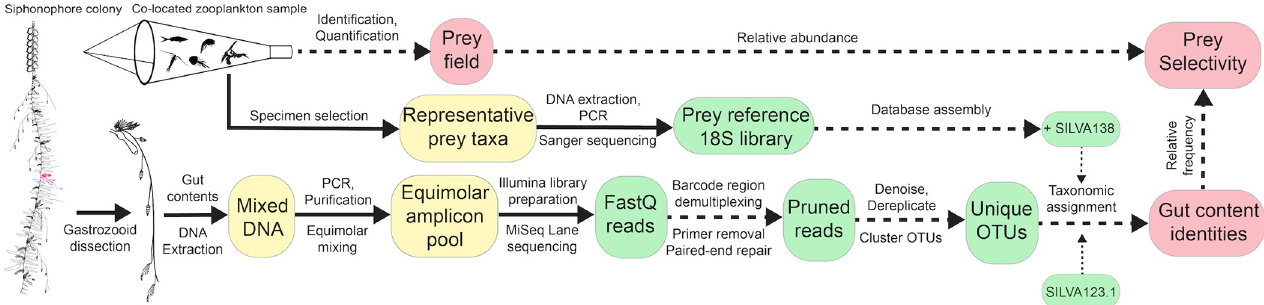
Fig 1. Gut content metabarcoding workflow used in this study. Siphonophore colony illustrated by Freya Goetz. Silhouettes in the plankton net downloaded from phylopic.org. Solid arrows indicate physical material transfer and processing, dashed lines indicate information transfer and processing. Yellow islands indicate elements processed in the laboratory bench, green islands represent bioinformatic datasets processed in the high-performance computing cluster, and red islands represent curated data products.